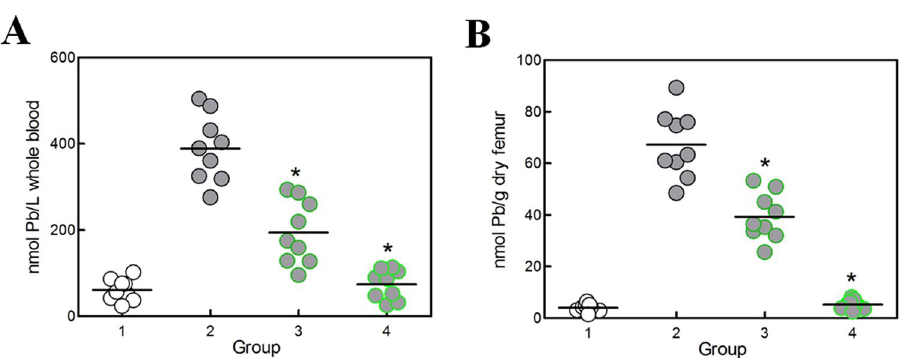
Figure 5. Lead content in whole blood ( A ) and femur ( B ) in mice. Male KM mice were given no lead (group 1), lead acetate + Lpp-OmpA displayed E . coli (group 2), saturatedly leaded PbrR-displayed E . coli (group 3), and unsaturatedly leaded PbrR-displayed E . coli (group 4), in a dose of about 20 μ g lead/mouse daily. Blood and femur were harvested on day 15, and lead concentrations were determined. Each circle represents one sample (n = 9), and the bars indicated the mean values. * A significant difference (One-way ANOVA statistical analysis, P < 0.001) when compared to group 2, while there is no significant difference between group 1 and group